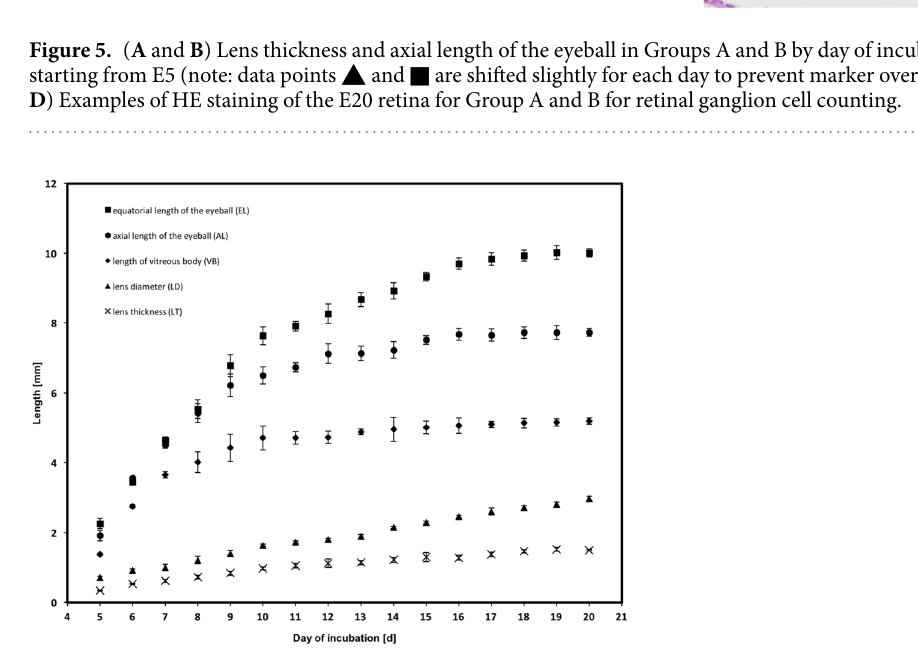
Figure 6. Changes in biometric dimensions EL, AL, VB, LD and LT over the incubation period, as measured by